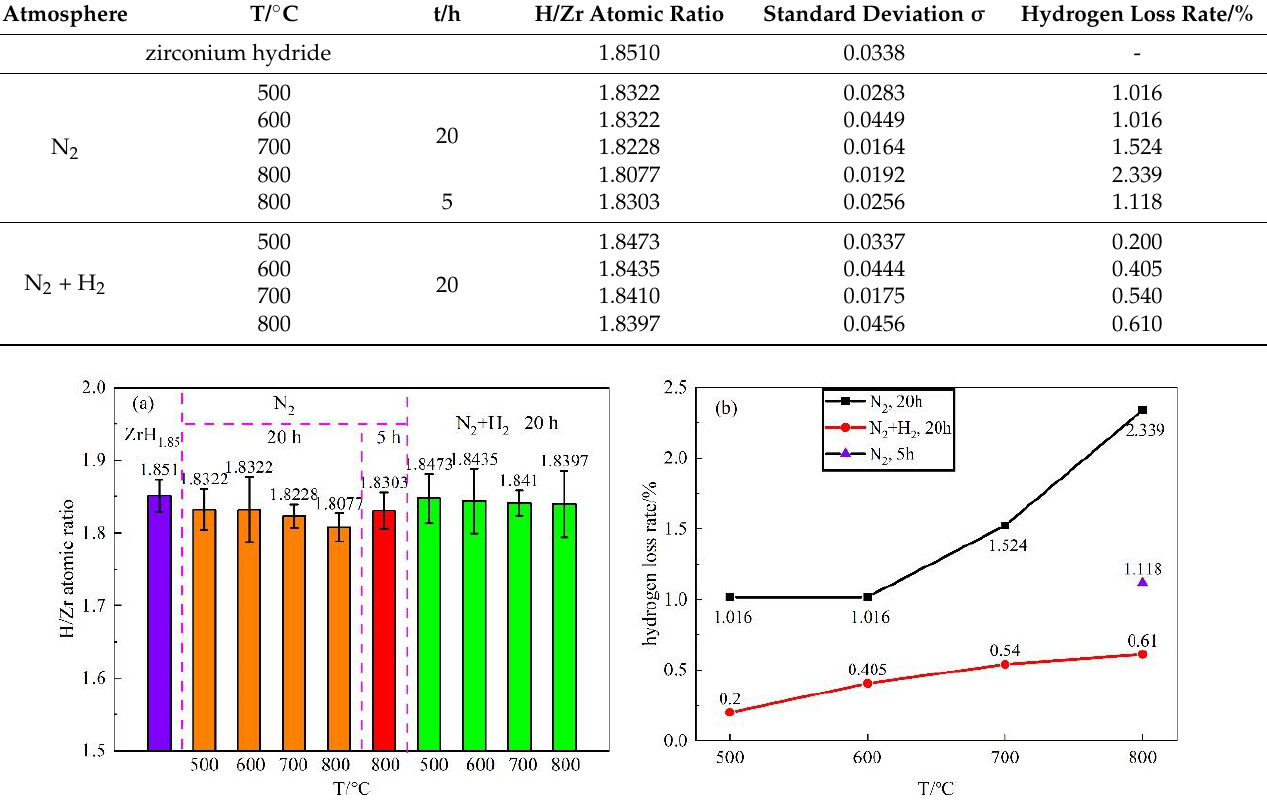
Figure 1. H/Zr atomic ratio and hydrogen loss rate of zirconium hydride matrix when film prepared in N 2 and N 2 + H 2 atmosphere ( a ) H/Zr atomic ratio; ( b ) hydrogen loss rate.